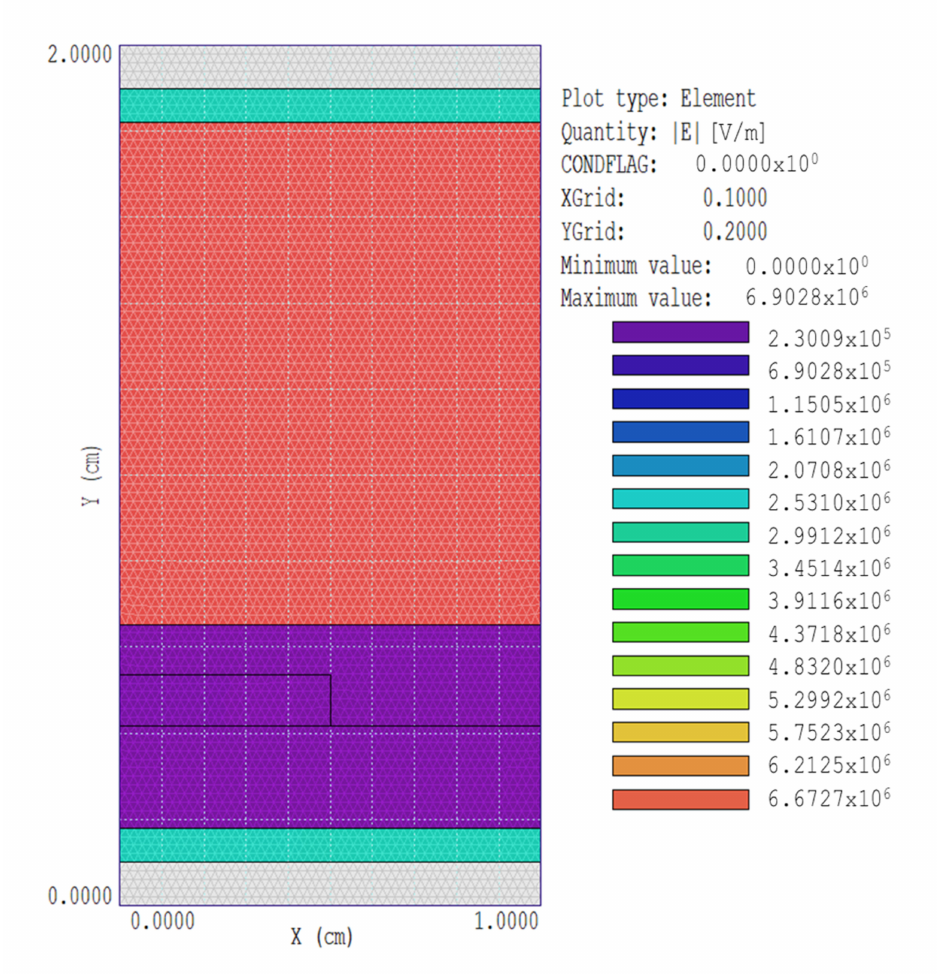
Figure 11. Simulation result of electric field distribution for configuration